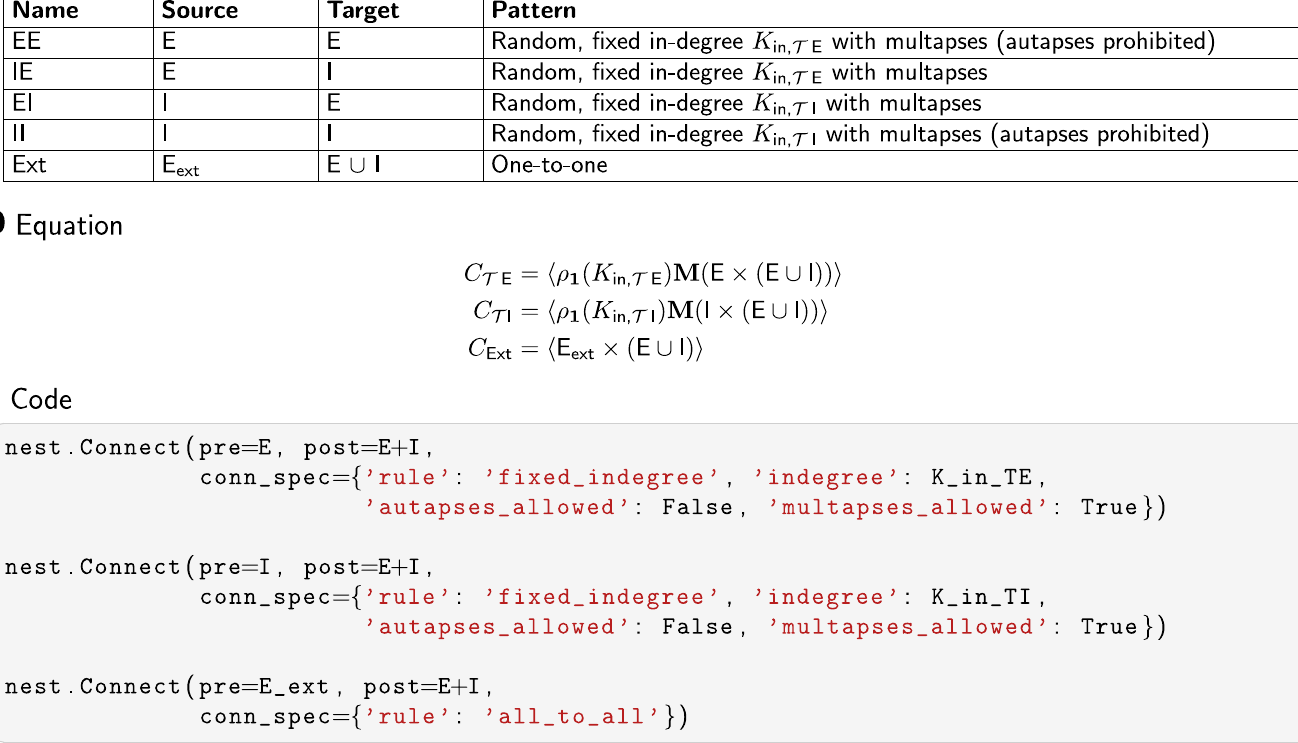
Fig 9. Different means to describe connectivity of a balanced random network. Example descriptions for the model used in Fig 1A with description means similar to Fig 3B. (A) Network diagram according to the graphical notation introduced in Section “Proposal for a graphical notation for network models”. Symbols in annotations refer to the concepts and not the explicit parameters. (B) Textual description of the model layout. Subscript “ T E ” labels connections from source population E to target population T 2 E ; I gf ; the same applies to “ T I ” with source population I. K and K represent the explicit values used for the in-degrees. (C) Table according to in ; T E in ; T I the guidelines by Nordlie et al. [84]. (D) Equations according to the Connection Set Algebra (CSA) [58] using the index sets E and I . (E) PyNEST source code [63] specifying connections from source ( pre ) to target ( post ) populations with a connection dictionary ( conn_spec ). The use of all-to-all instead of one-to-one connectivity here is due to the specific implementation of the external drive in